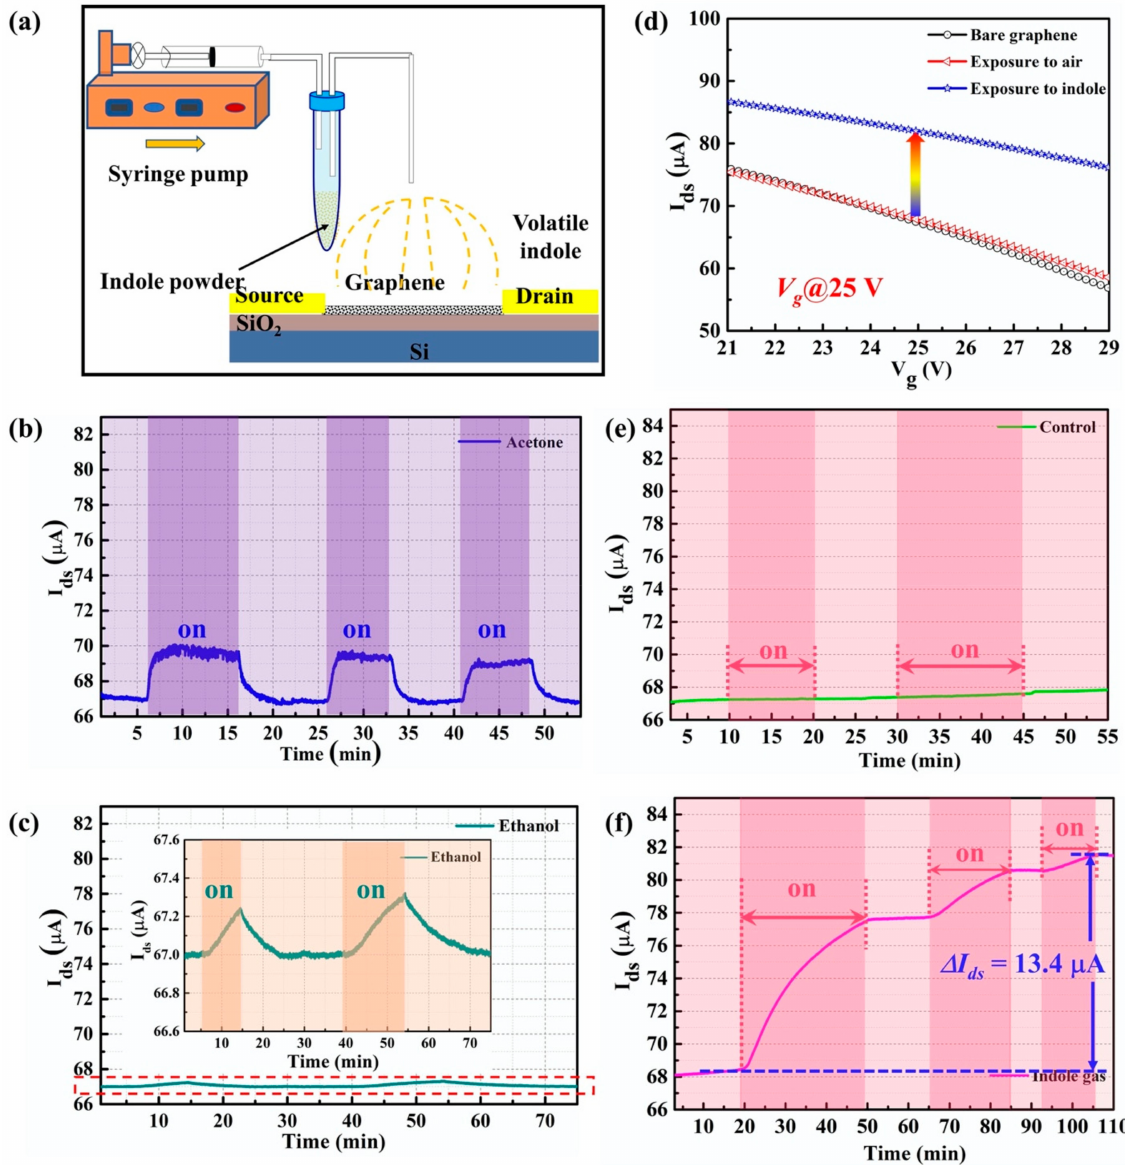
Figure 6. ( a ) The experimental setup of gas-phase indole detection. ( b ) The real-time response of acetone using the G-FET biosensor. ( c ) The real-time response of ethanol using the G-FET biosensor. ( d ) The transfer characteristics of graphene channel before and after the exposure of the gas-phase indole. ( e ) The control experiment using air gas. ( f ) The real-time detection of indole gas molecules using the G-FET